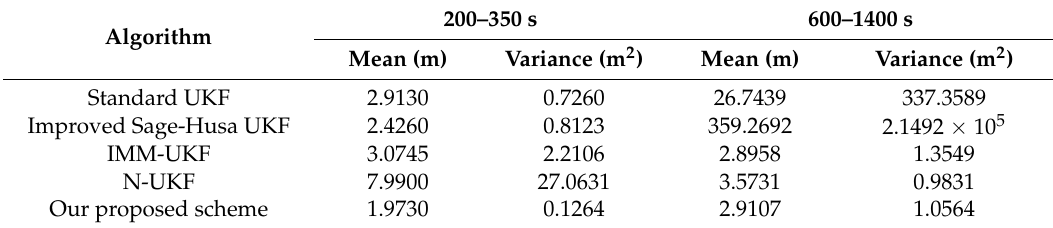
Figure 4. Position tracking errors for Case 2. Table 2. Position errors of the different schemes for Case 2.